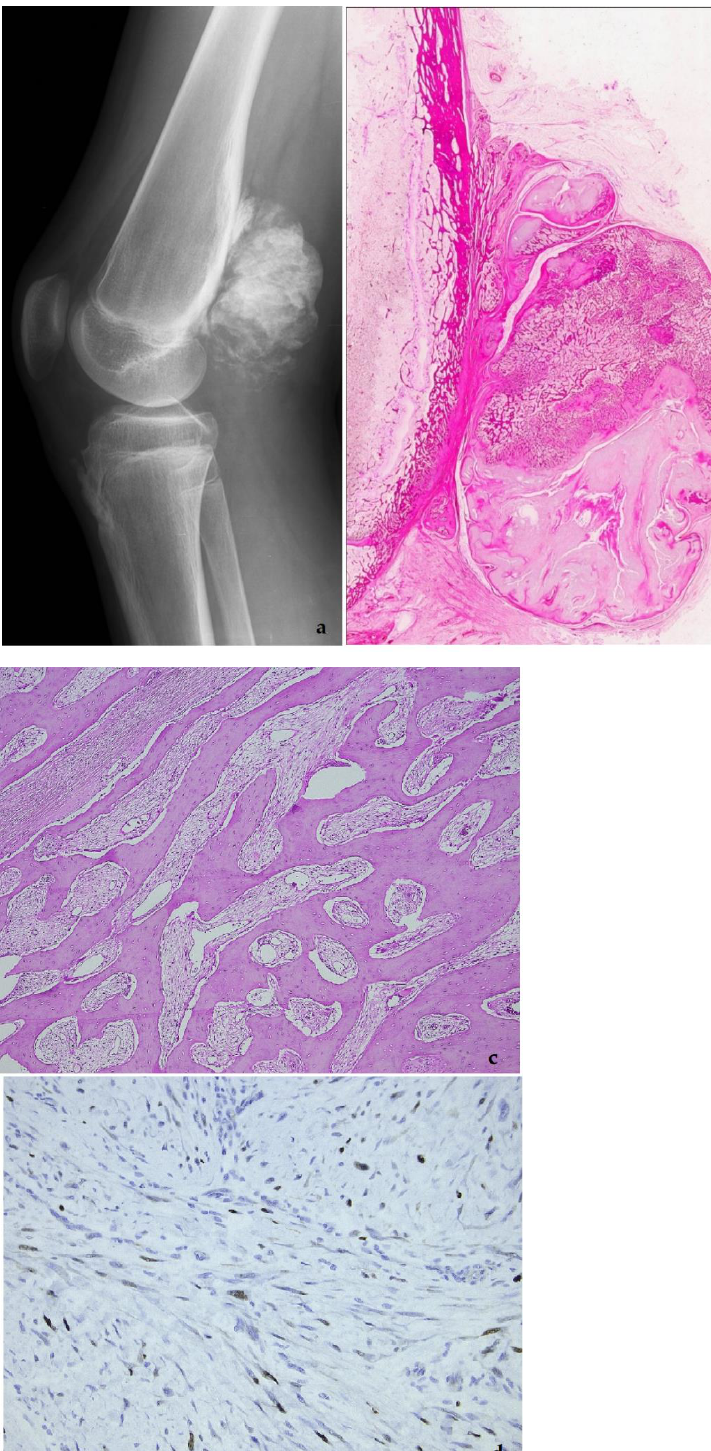
Figure 11. Parosteal osteosarcoma, typically presenting as a mineralized mass at the back of the distal femur, X-ray ( a ), and whole mount section ( b ). At high power, the tumor consists of parallel bone trabeculae and a typical spindle cell proliferation ( c ). MDM2 expression is present as well ( d ).